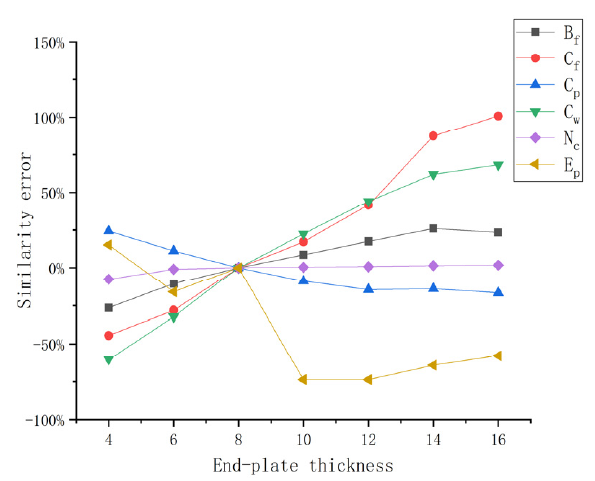
Figure 24. Similarity errors of different end-plate thicknesses at specified points.